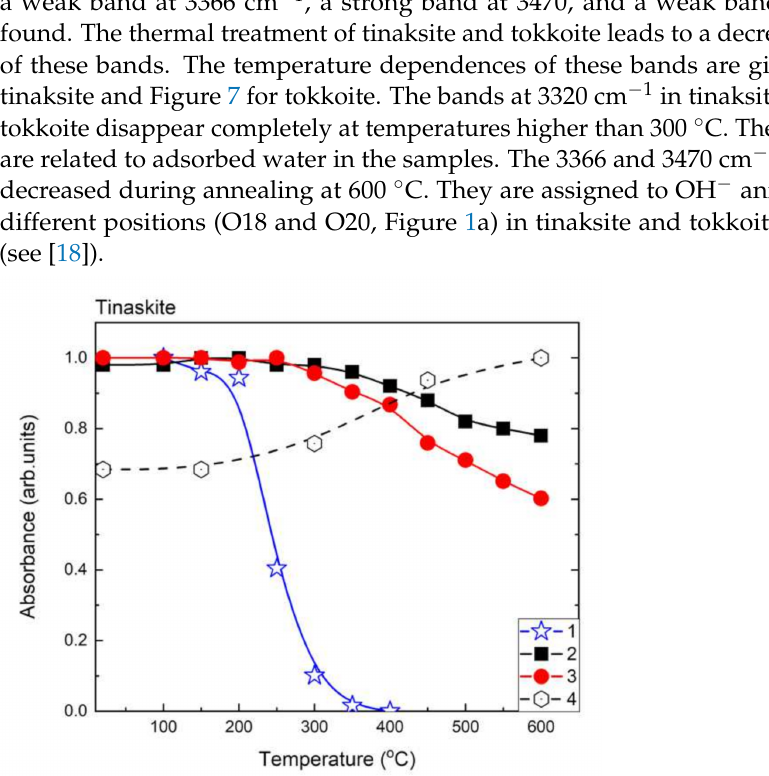
Figure 6. Temperature dependences of relative absorbance of 3320 cm − 1 ( 1 ); 3366 cm − 1 ( 2 ); 3470 cm − 1 ( 3 ) bands and intensity of Fe 3+ signal in ESR spectrum ( 4 ) of tinaksite.